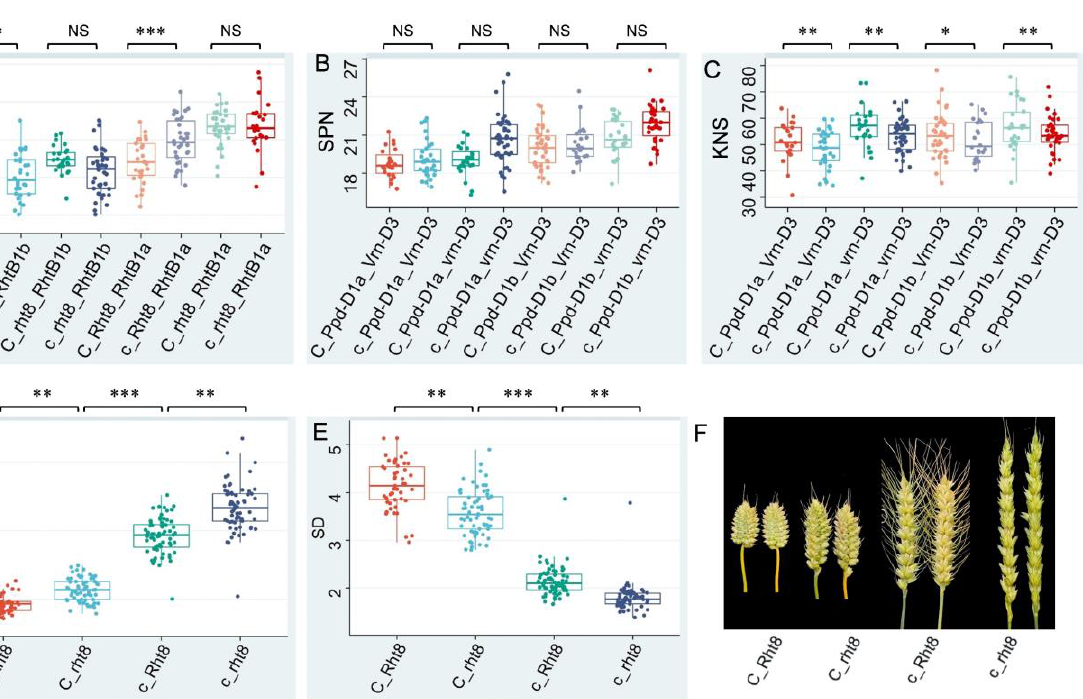
Figure 5 . Genetic effects of various gene combinations between C and plant height and four spike and grain-related traits. ( A ) The combined effects of C , Rht8 and Rht1 on plant height (PH); ( B ) The combined effects of C , PPD-D1 and Vrn-D3 on total spikelet number per spike (SPN); ( C ) The combined effects of C , PPD-D1 and Vrn-D3 on number of kernels per spike (KNS); ( D ) The combined effects of C and Rht8 on spike length (SL); ( E ) The combined effects of C and Rht8 on spike density (SD); ( F ) The spike morphology of C and Rht8 combinations. Traits that show significant mean difference between genotypes are indicated by * p < 0.05, ** p < 0.01 or *** p < 0.001 (Student’s t test). NS is “Non -signific ance”.